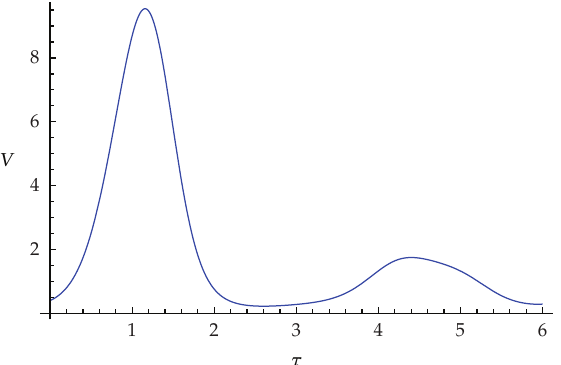
Figure 6: The evolution of the volume for (cid:2) 3.12 (cid:3) with A 0 (cid:6) B 0 (cid:6) C 0 (cid:6) V 0 (cid:6) 1.